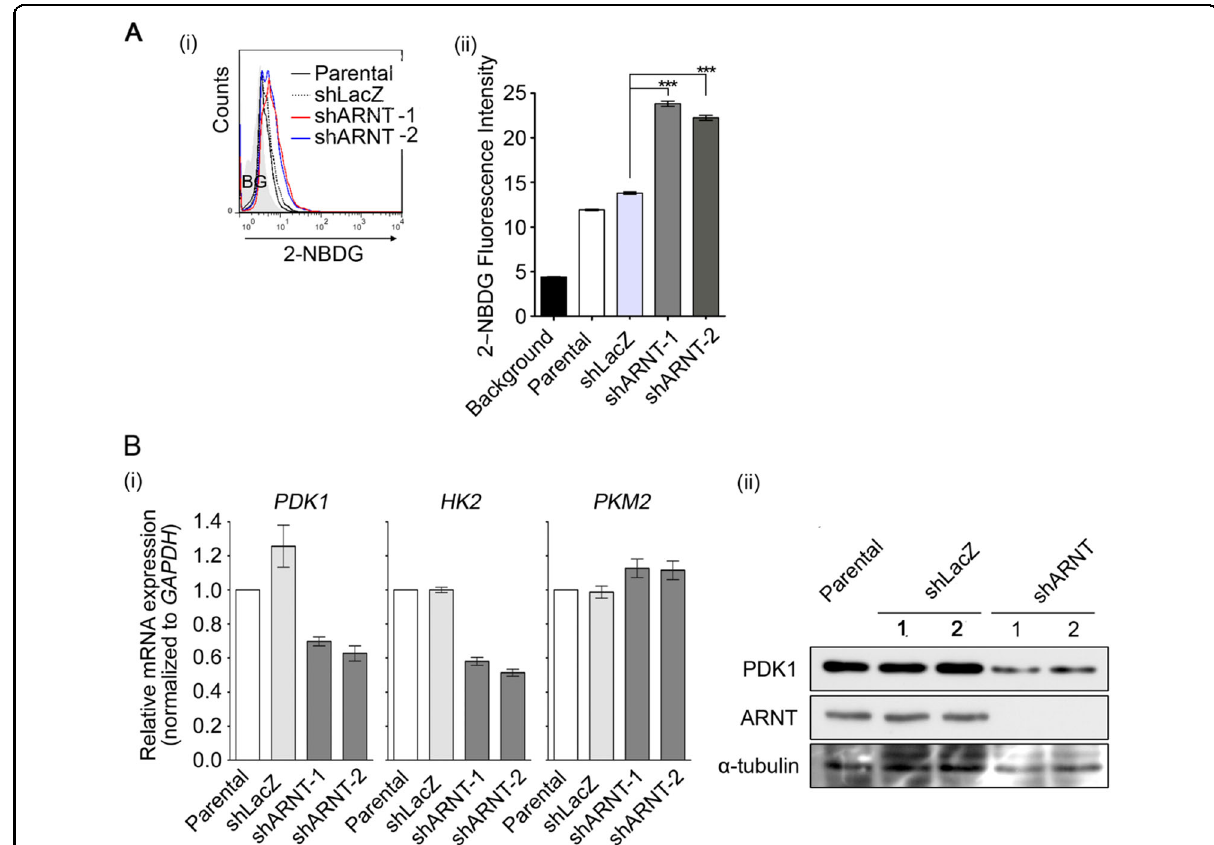
Fig. 4 Increase of glucose consumption but downregulation of PDK1 expression is presented in ARNT-depleted cells. A The glucose consumption rate was analyzed by 2-NBDG uptake in shARNT cells. A375 cells were incubated in 2-NBDG/PBS (10 μ M) solution for 30 min, and then the 2-NBDG signal was analyzed by fl ow-cytometry (i). The fl uorescence intensity of 2-NBDG from 5000 individual cells were statistically analyzed by Prism 6.0 software (ii). B Gene expression of PDK1 , HK2 , and PKM2 was analyzed by quantitative real-time PCR in shARNT cells (i). Protein expression level of PDK1, ARNT and α -tubulin was evaluated by Western blotting with antibodies against PDK1, ARNT and α -tubulin in shARNT A375 cells